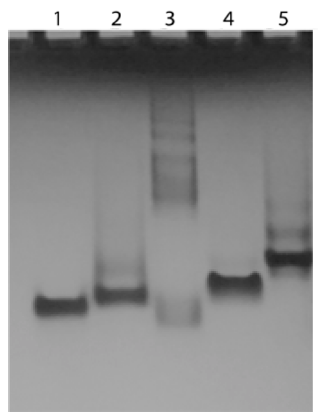
Figure 8. Electrophoresis mobility shift assay of the conjugated and unmodified sequences. Lane 1: (cid:48) -TT-T30695; lane 3: 5 (cid:48) -DMAzo-TBA; lane 4: 5 (cid:48) -DMAzo-T30695 and lane 5: TBA; lane 2: 5’-TT-T30695; lane 3: 5’-DMAzo-TBA; lane 4: 5’-DMAzo-T30695 and lane 5: T30695. TBA; lane 2: 5